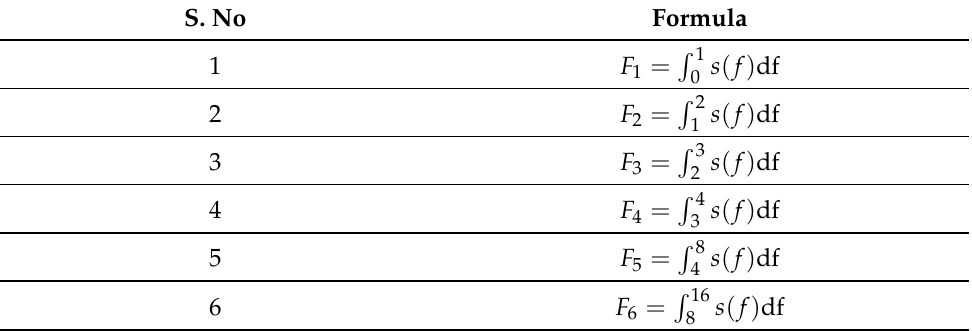
Table 1. Modified frequency marginal